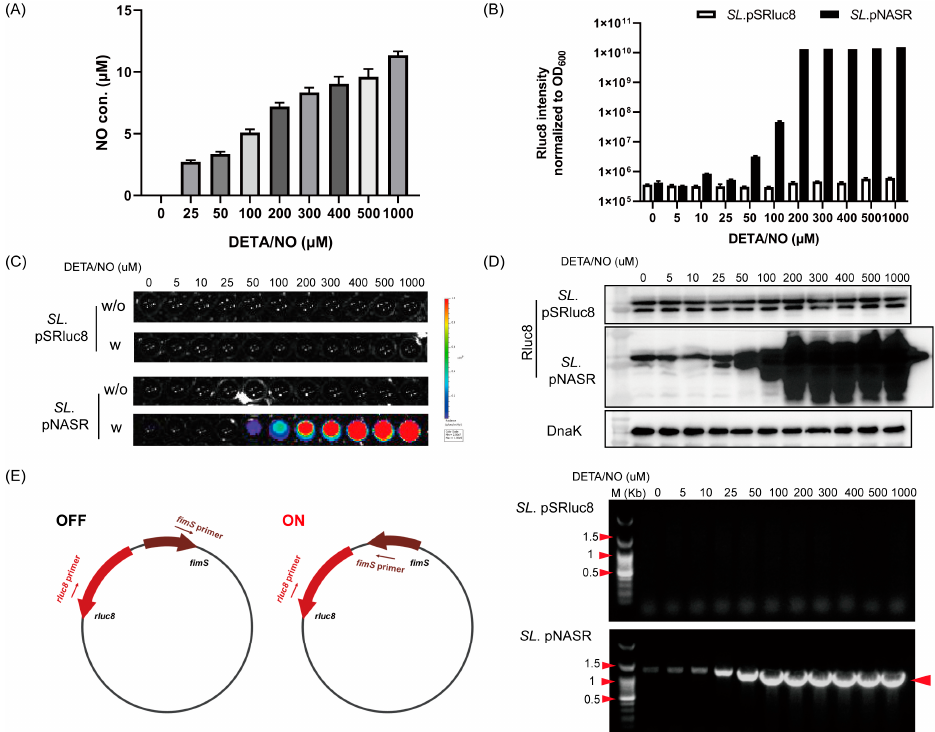
Figure 3. Dose responsive analysis of the NO-sensing switch system. ( A ) NO release by different concentrations of DETA/NO in bacterial culture medium after incubation at 37 °C for 16 h. ( B ) Rluc8 intensity in SL . pNASR and SL . pSRluc8 cultured in the presence of indicated concentrations of DETA/NO for 16 h at 37 °C. Rluc8 intensity was measured with 0.2 μ g of coelenterazine and nor- malized to the number of bacterial cells (OD 600 ). ( C ) Bioluminescence images of SL . pSRluc8 (upper panel) and SL . pNASR (bottom panel) from ( B ). w / o , without coelenterazine; w , with coelenterazine. ( D ) Western blot analysis of Rluc8 expression in bacterial samples from ( B ) using anti- Renilla lucif- erase antibody (upper panel). Rluc8 expression was normalized to DnaK expression, as detected with anti-DnaK antibody (bottom panel). ( E ) Switch activation verified by PCR amplification. Left, illustration of ON-state primer designation; right, PCR results using ON-state primer set to confirm switch activation in bacterial cells from ( B ). Bands appeared when fimS was switched and in the same direction as rluc8 (~1.1 Kbp, arrow).